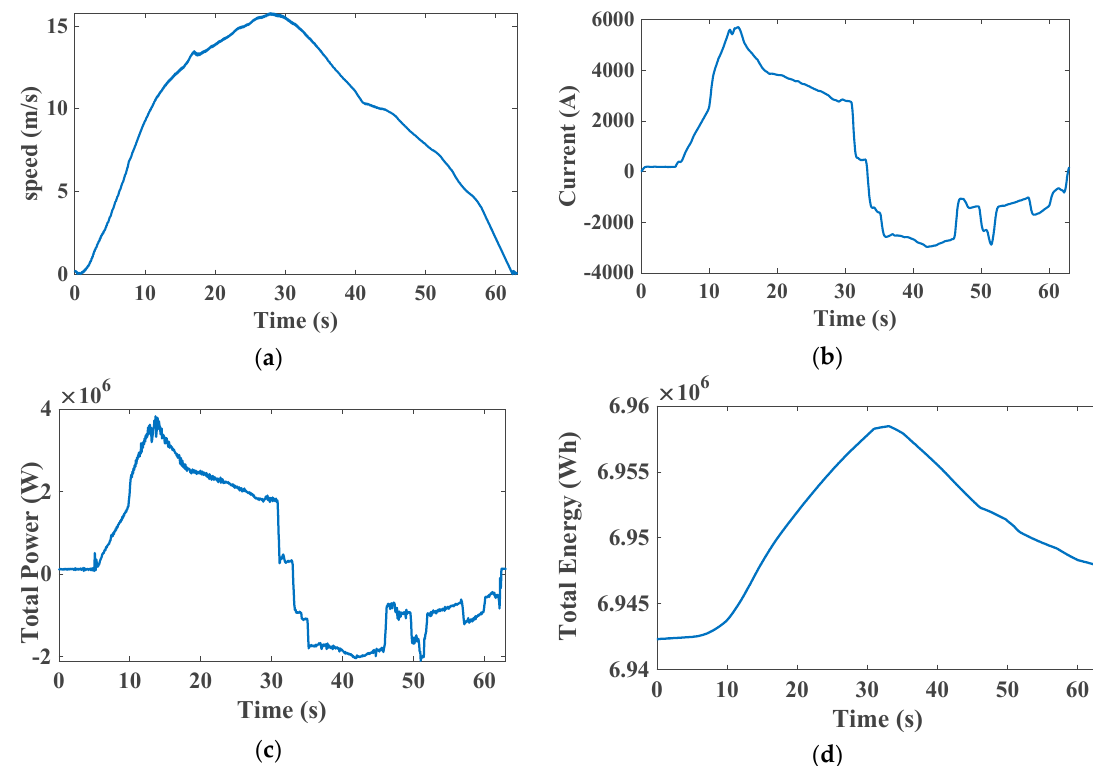
Figure 10. Train performance profile; ( a ) speed, ( b ) current, ( c ) power, and ( d ) energy.